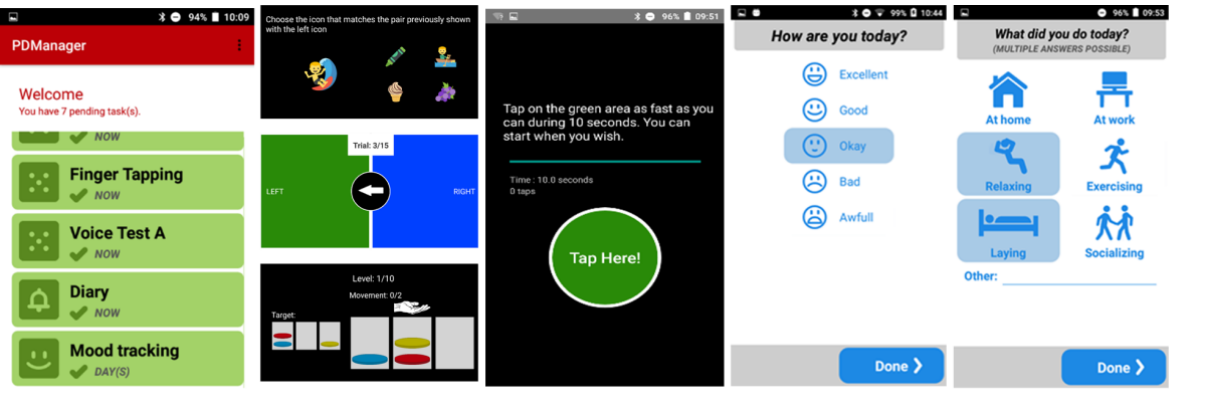
Figure 2. Screenshots from mobile app. From left to right: tasks patient must perform, some cognitive tests, finger-tapping test, mood monitoring diary.